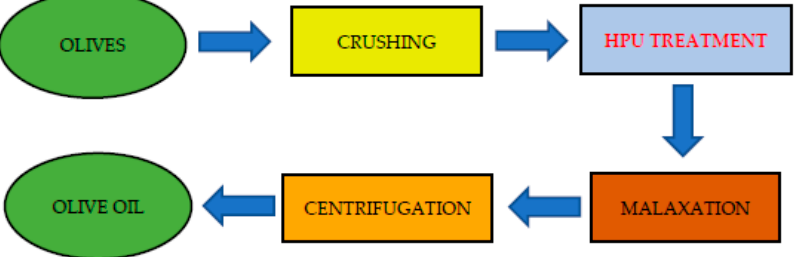
Figure 1. Flow chart of the olive oil production process with the HPU treatment